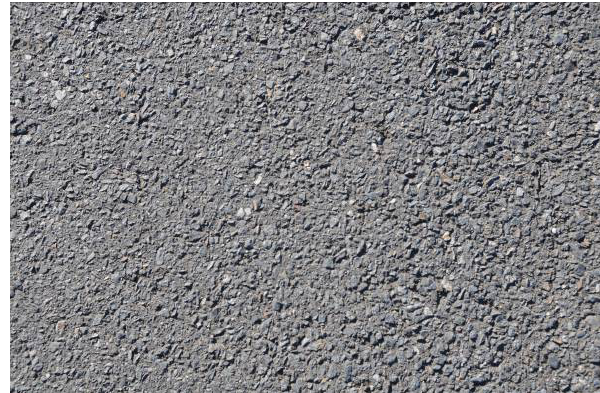
Fig. 3. Aggregate of bitumen test site, Dorset Road, Bayswater, Victoria, Australia.